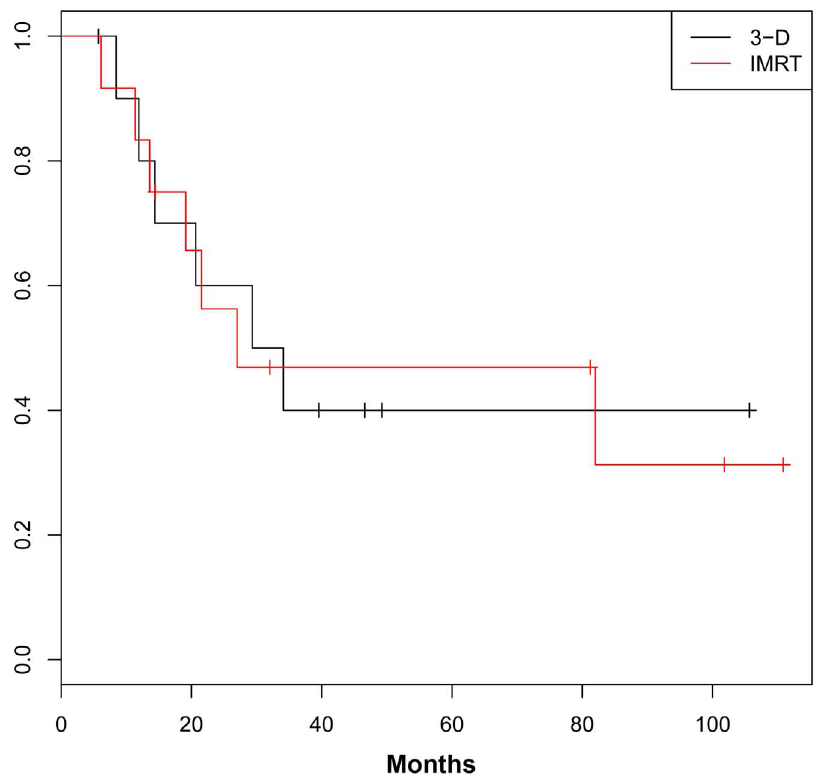
Figure 2. Overall Survival.